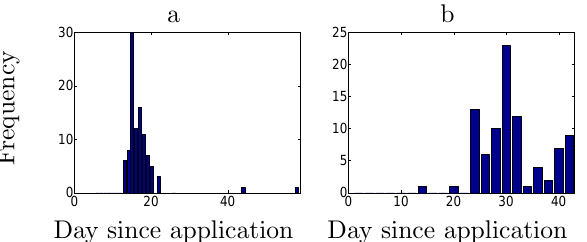
Fig. 8. Histograms of the daynumber on which the peak bromide concentration occurred, for the snowmelt experiment (a) , and the irrigation experiment (b) . Application was on March 26 2010 (a) , and May 23 2010 (b) .